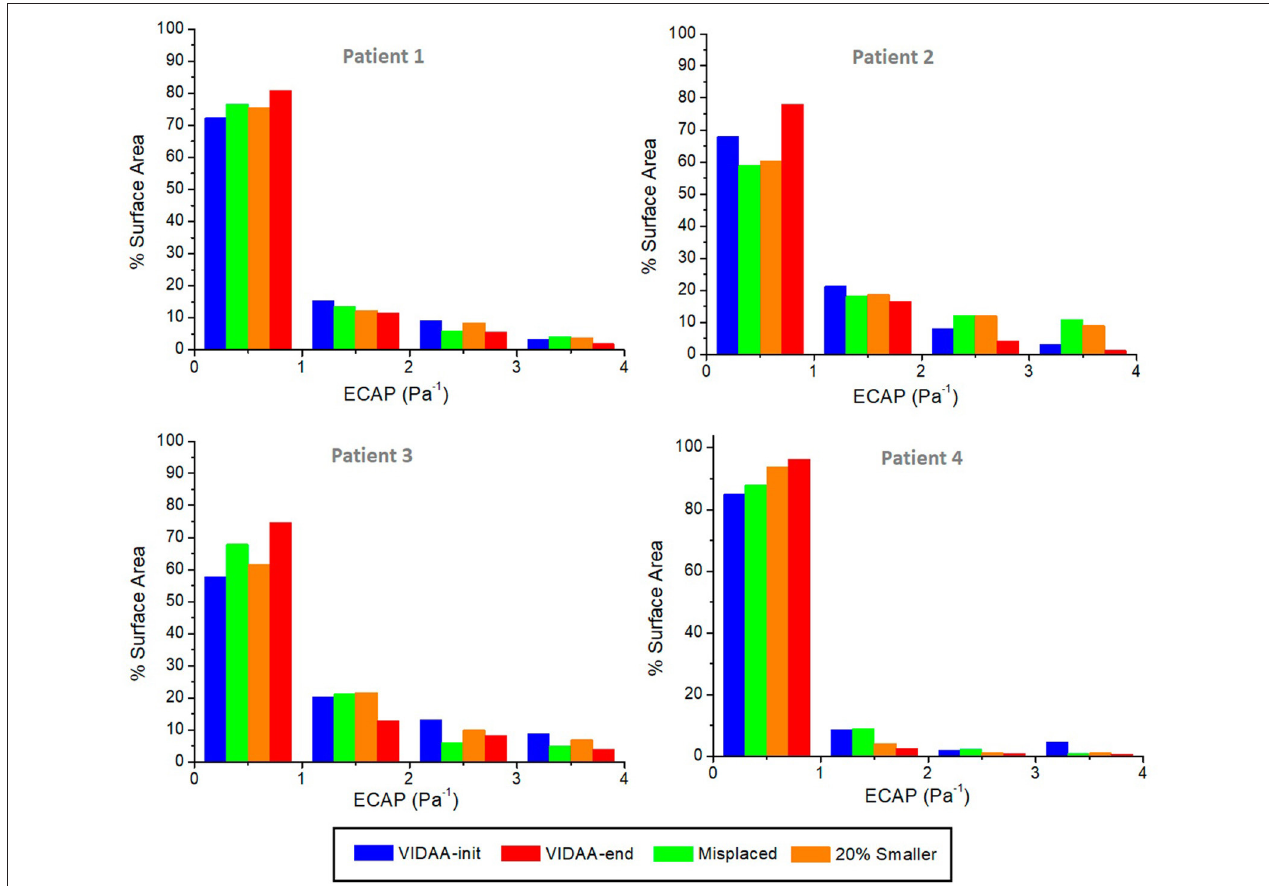
FIGURE 8 | Histograms of Endothelial Cell Activation Potential (ECAP) distribution (Pa − 1 ) as a percentage of surface area for each patient and different device scenarios. VIDAA-init: device settings from morphological analysis and clinical recommendations; VIDAA-end: device settings after interactive manipulation in VIDAA; 20% smaller: device with a 20% smaller size than VIDAA-init; Misplaced: device with sub-optimal position and